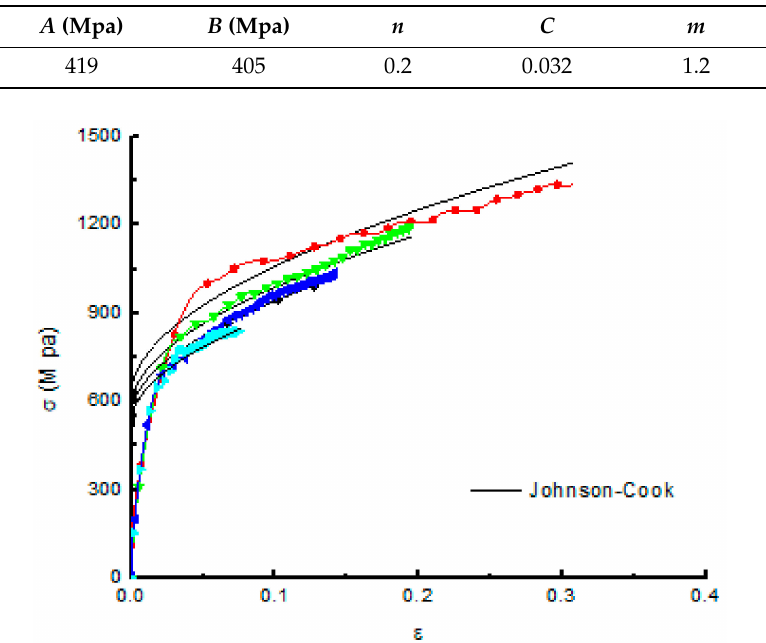
Table 4. Johnson–Cook parameters of gray cast iron.